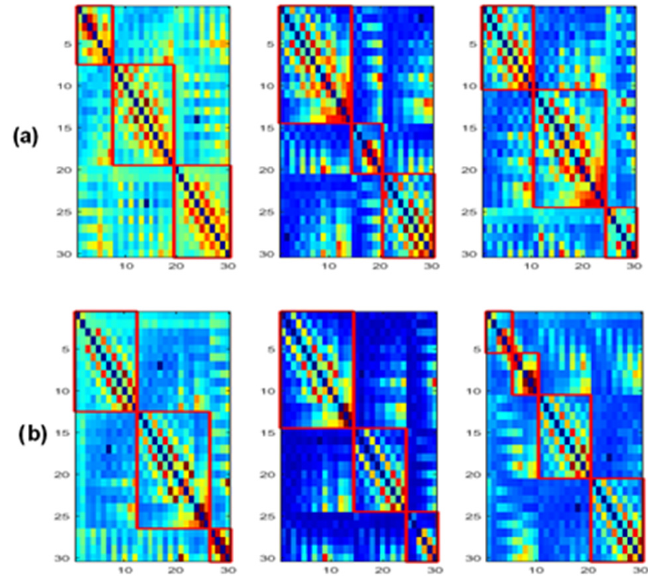
Figure 12. The obtained modules for SCI (left), MCI (middle) and AD (right) on the ( a ) alpha and ( b ) beta bands.